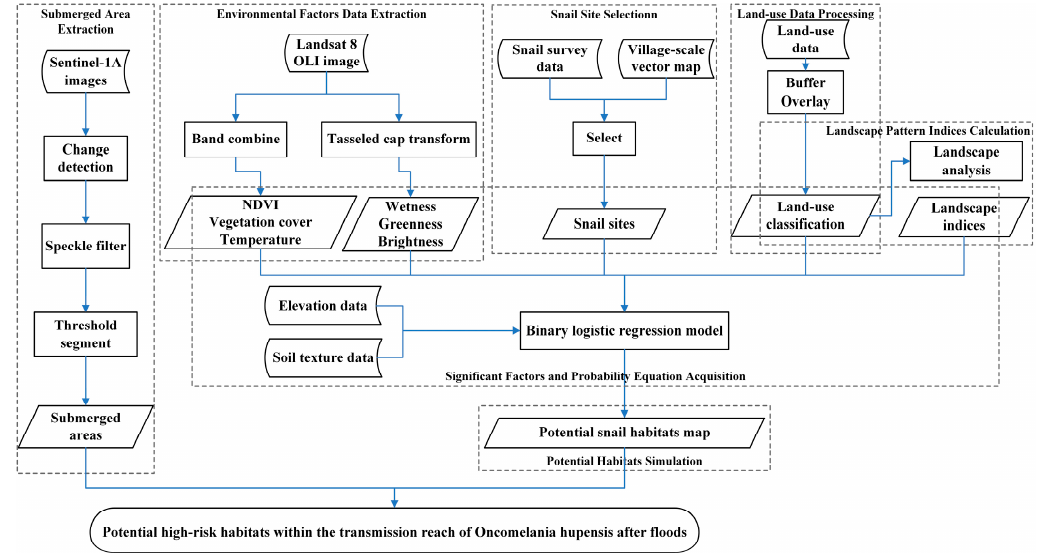
Figure 2. Data processing steps and technology roadmap.